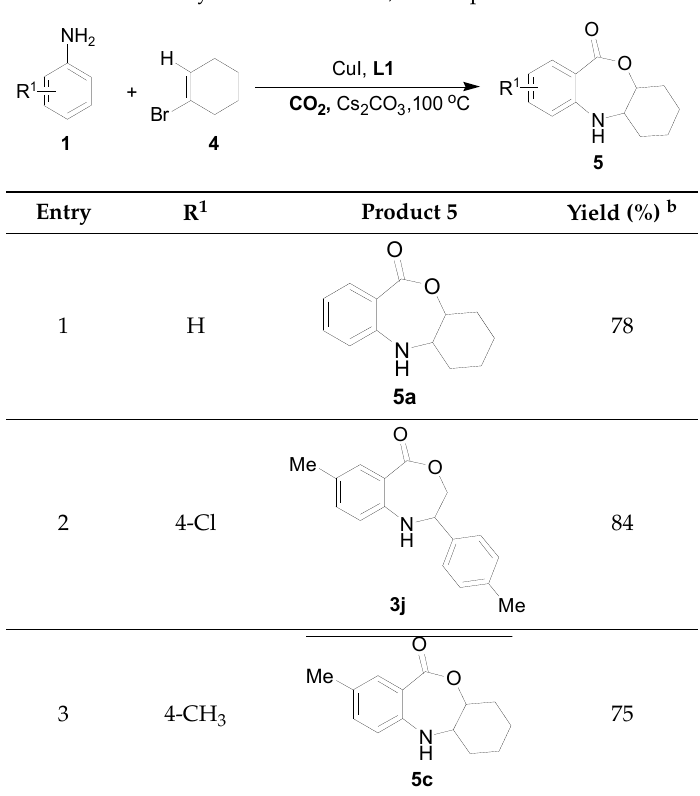
Table 3. Synthesis of benzo-1,4-oxazepin-5-one 5 a .